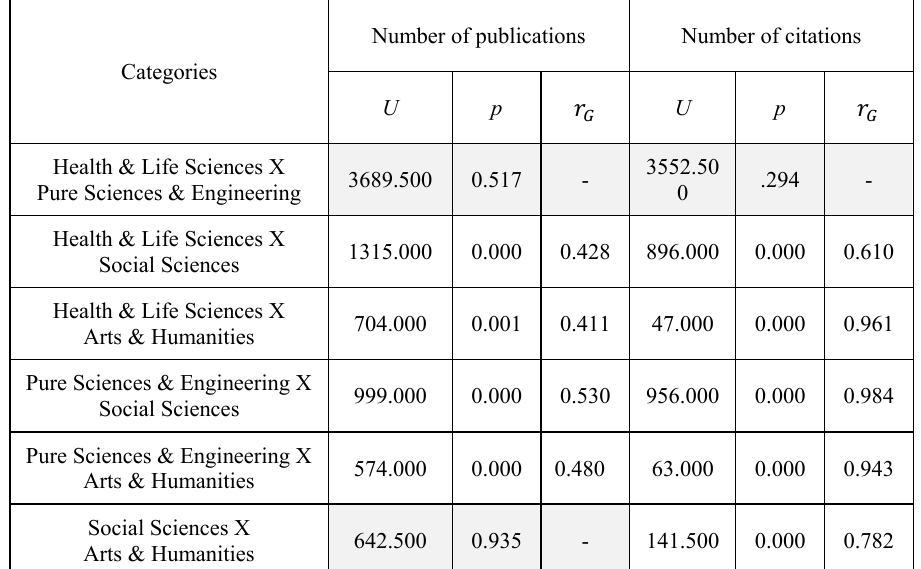
Table 2. Mann-Whitney test results.